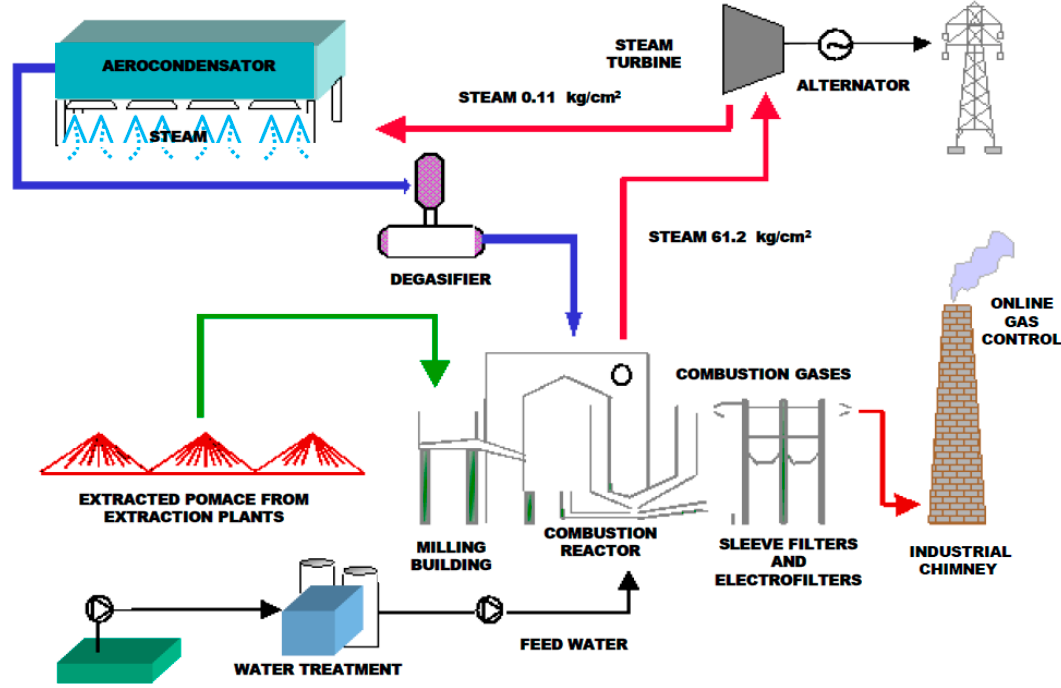
Figure 11. Industrial production of electrical energy using extracted pomace from extraction plants in in Spain.